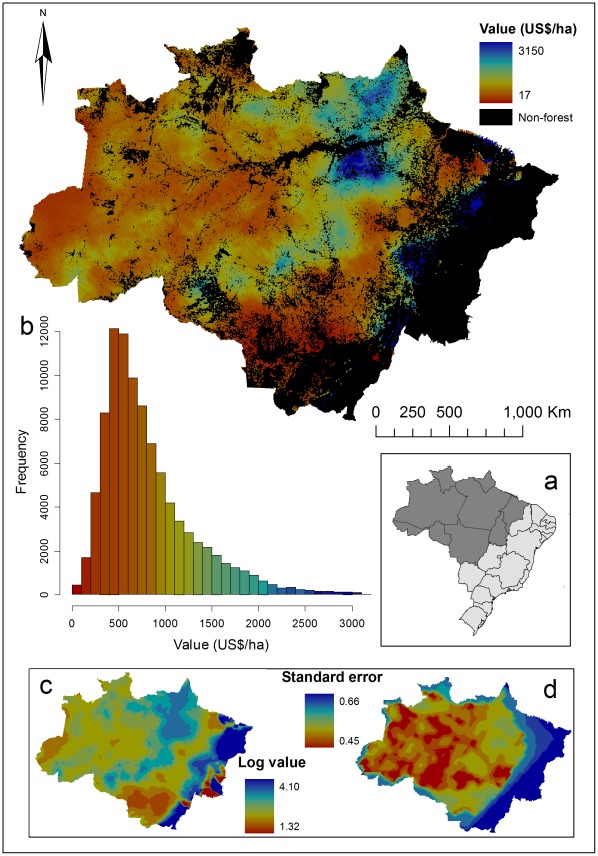
Map of timber value in the Amazon.Values range from low (US$17 per ha) to high (US$3150 per ha). Insets: (a) dark shading shows the spatial extent of the Brazilian Amazon within Brazil, including the state boundaries; (b) frequency distribution of timber values (US$.ha−1) in the Brazilian Amazon, calculated over 151,073,784 equal-area grid squares of area 0.25 km2; (c) log- transformed timber value across the Amazon without non-forest areas removed (the raw outputs from the kriging analysis). As non-forest areas are not removed the maximum predicted value in panel (c) is 4.10, equating to US$4400 per ha, is higher than the maximum value of US$3150 per ha in panel (a). This discrepancy arises because the maximum values in panel (c) occur along the eastern margins of the Amazon where, in fact, there is little forest standing. (d) standard error of predicted log-transformed timber value.